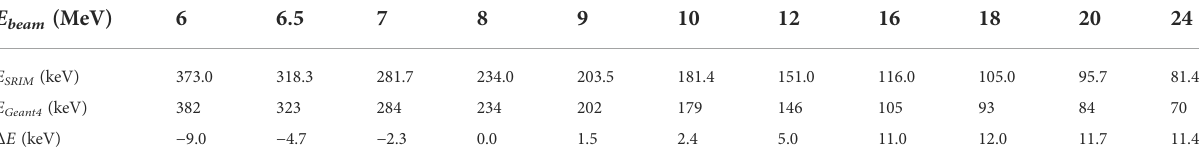
TABLE 1 Values of the energy deposited in the SV by the protons obtained with SRIM and Geant4 simulations for the different beam energies used in this work, and difference between the two sets of values ( Δ E